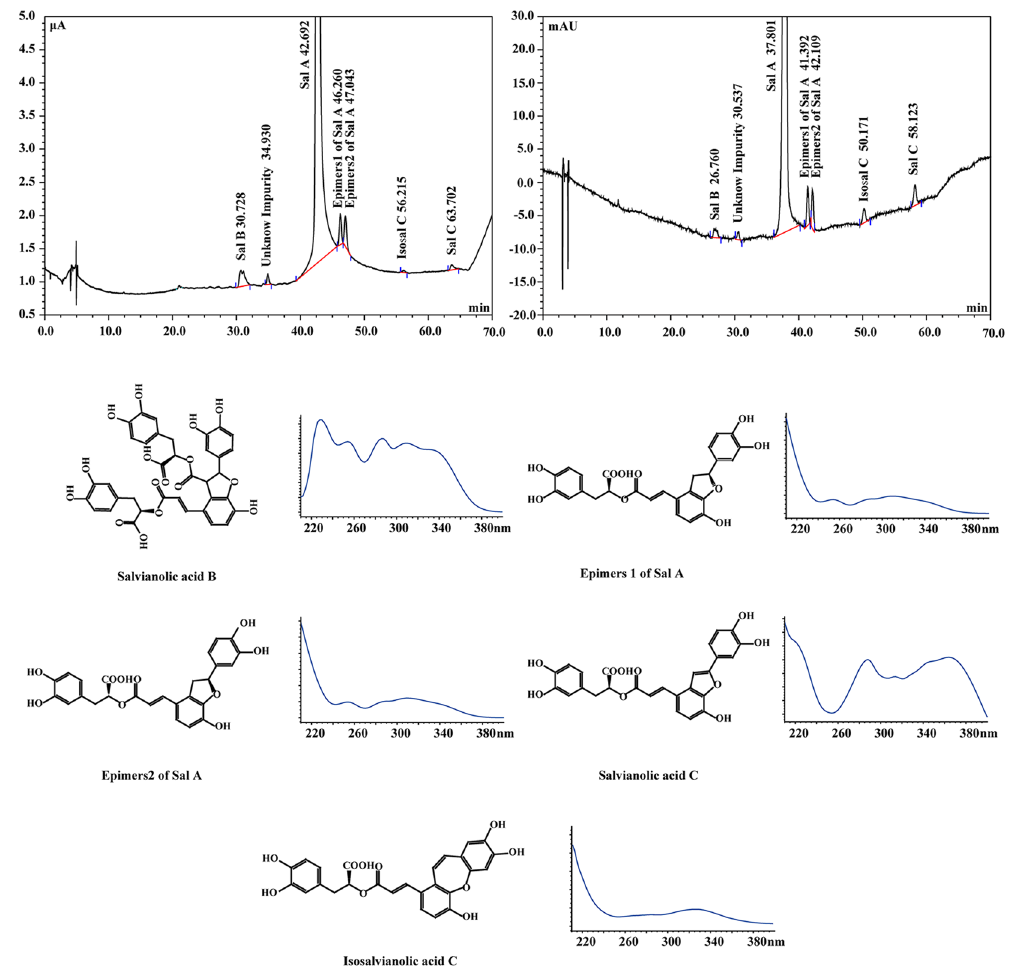
Fig. 2 Typical ECD and DAD chromatograms and ultraviolet absorption spectrum of Sal A and